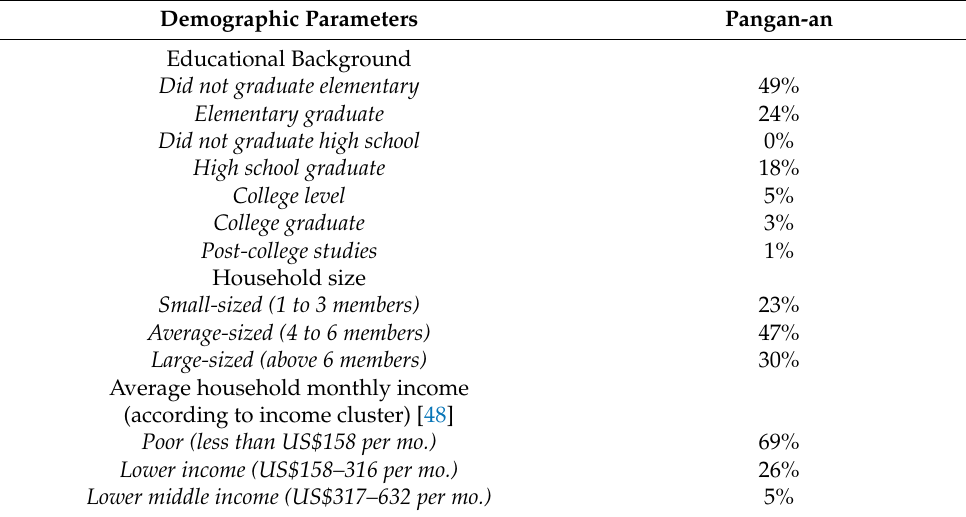
Table 1. Demographic profile of Pangan-an Island.